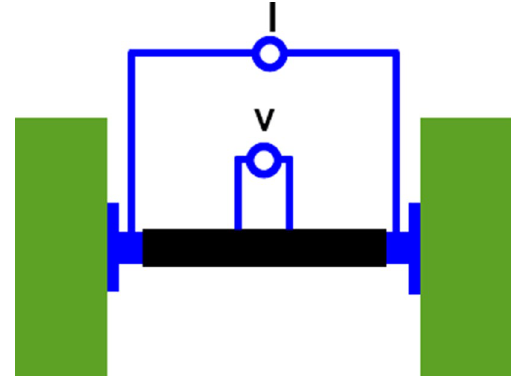
Fig. 1 A schematic representation of the sample holder used for the